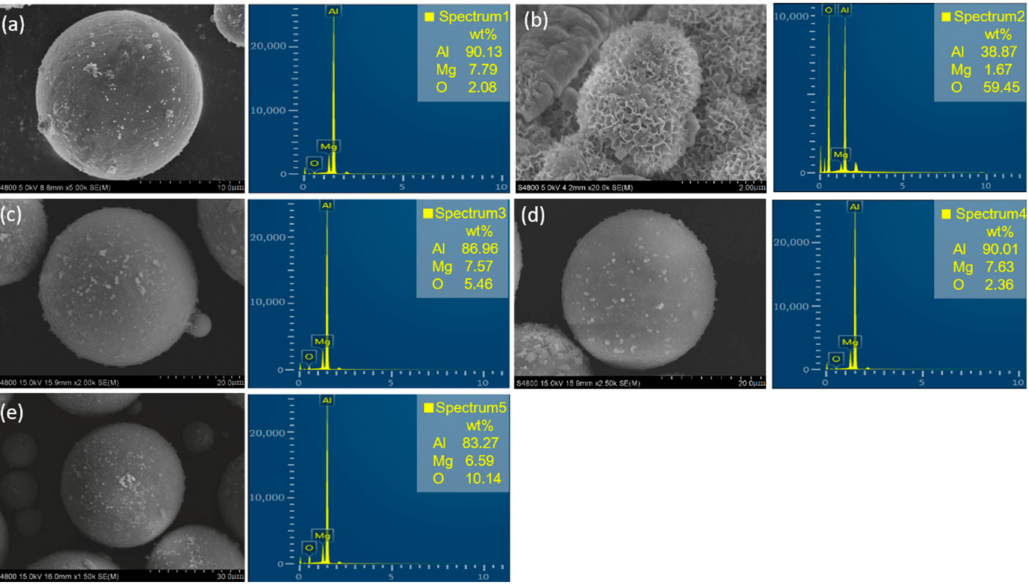
Figure 5. SEM micrographs and EDS of Al alloy dust before ( a ) and after ( b ) reaction in blank solution and those containing various inhibitor concentrations: 0.25 wt% PS ( c ), 0.75 wt% PE ( d ), 0.75 wt% HC ( e